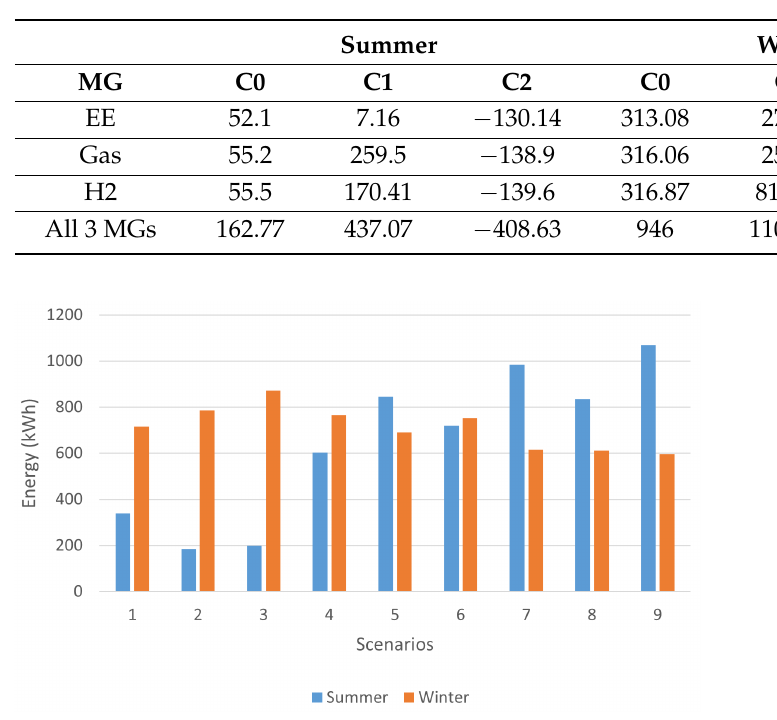
Table 2. The total costs (EUR) for cases C0, C1 and C2.